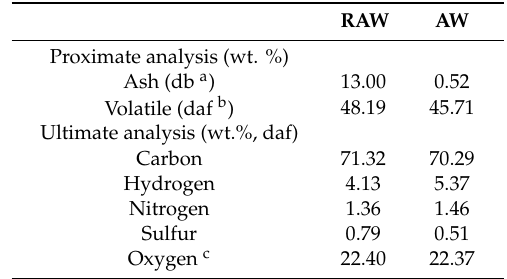
Table 4. Proximate and ultimate analysis of Pingzhuang